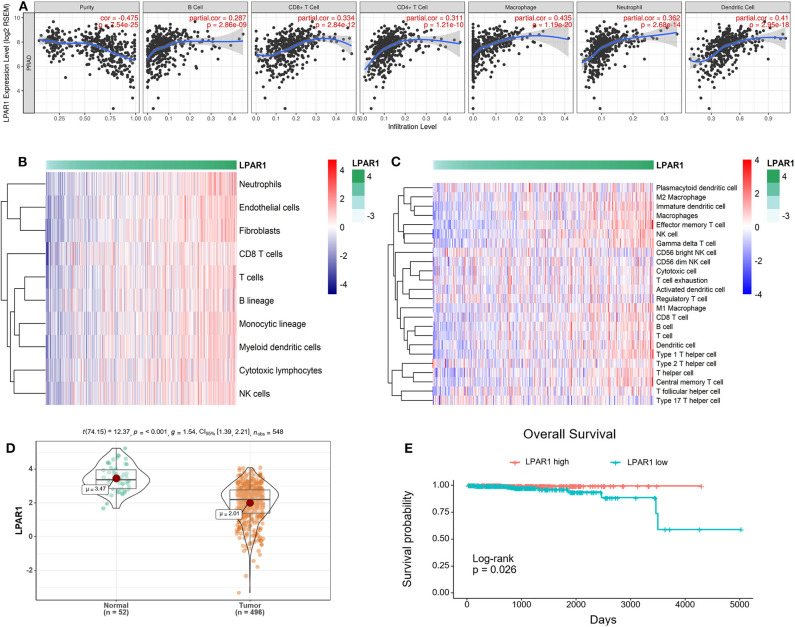
Correlation of lysophosphatidic acid receptor 1 (LPAR1) expression and tumor-infiltrating immune cells and prognosis in prostate adenocarcinoma (PRAD). (A) LPAR1 expression was significantly negatively related to tumor purity and had a positive correlation with the abundance of several immune cell types in PRAD, including CD8+ T cells, CD4+ T cells, macrophages, B cells, neutrophils, and dendritic cells. (B) Heatmap of the correlation between LPAR1 and T cells, B lineage, monocytic lineage, myeloid dendritic cells, cytotoxic lymphocytes, and natural killer cells as performed by the MCPcounter R package. Higher LPAR1 expression was associated with higher abundance of immune infiltrates in PRAD. (C) Heatmap of the correlation between LPAR1 and several immune cells based on ssGSEA R package. (D) Violin plot comparing the LPAR1 expression for patients with highly expressed LPAR1 vs. those with lowly expressed LPAR1 in prostate cancer with p-value < 0.001. (E) Kaplan–Meier plot comparing the overall survival for patients with highly expressed LPAR1 vs. those with lowly expressed LPAR1 in prostate cancer using log-rank test with p-value < 0.05.